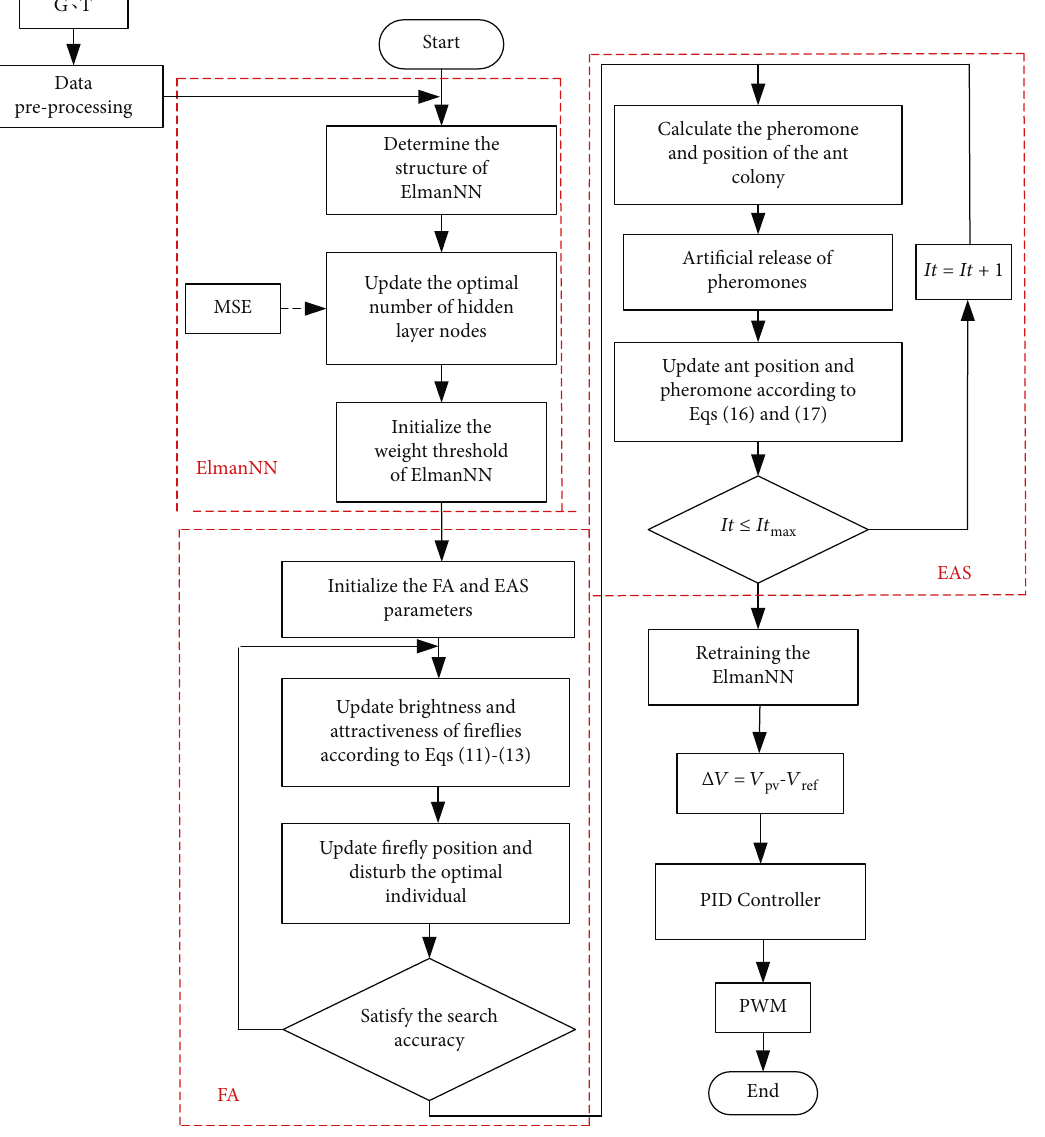
Figure 8: The fl ow chart of